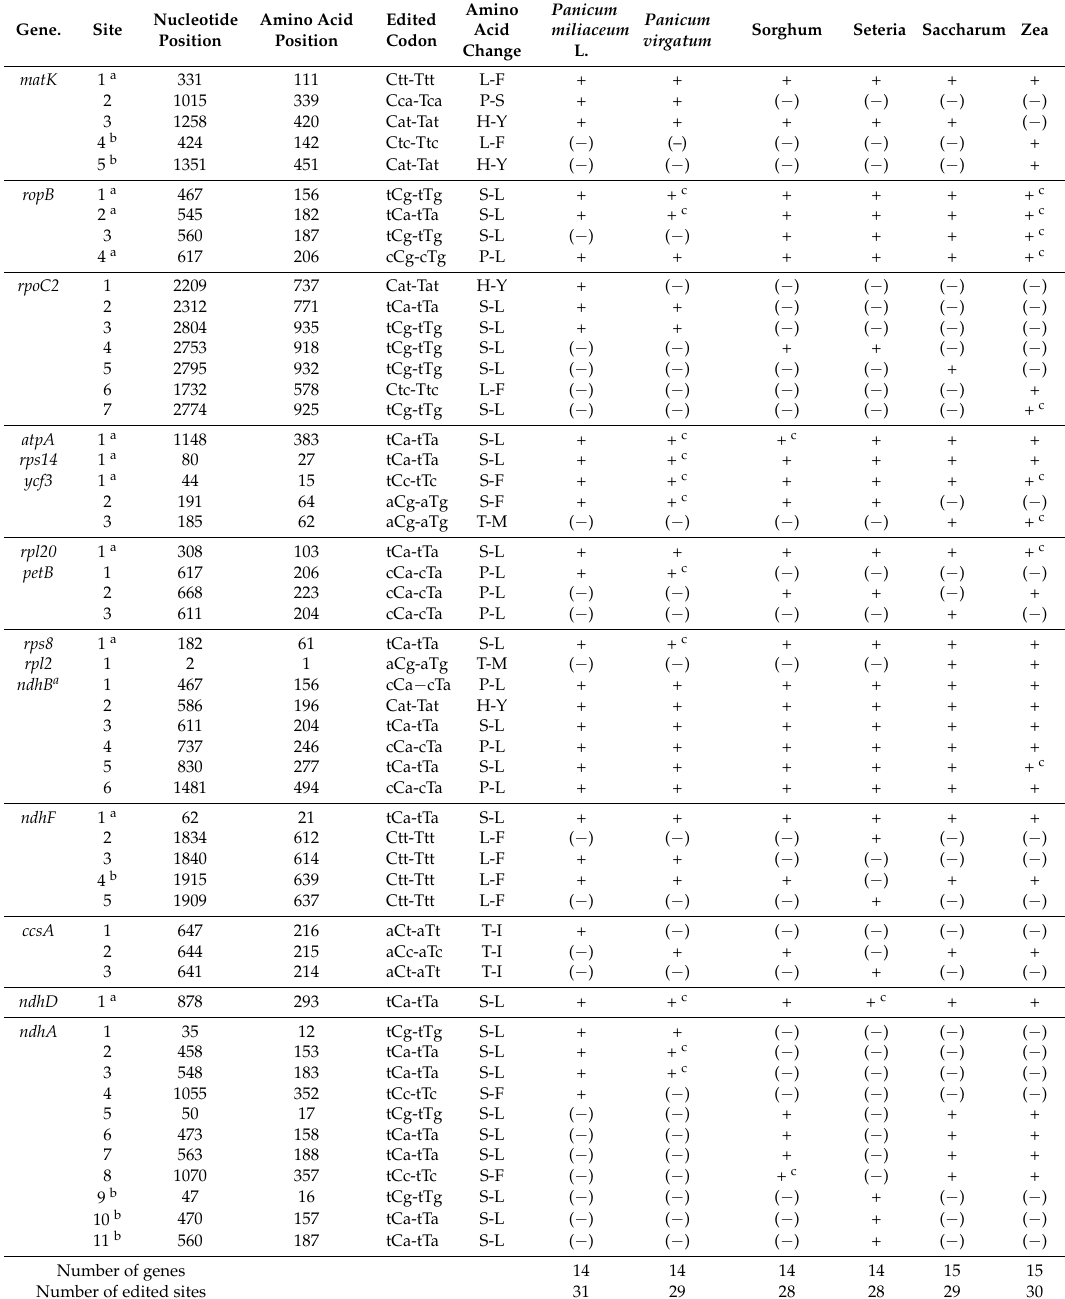
Table 5. RNA editing sites predicted in the chloroplast genome of broomcorn millet and five other Panicoideae species.